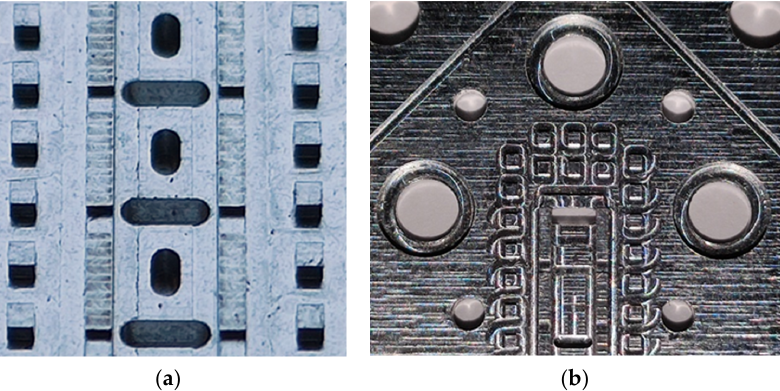
Figure 32. Detailed view of the manufactured single-periodic prototype. ( a ) Zoom of the central waveguide with stadium-shaped holes in T position and ( b ) zoom of the stepped right-angled bend transition to WR-10.